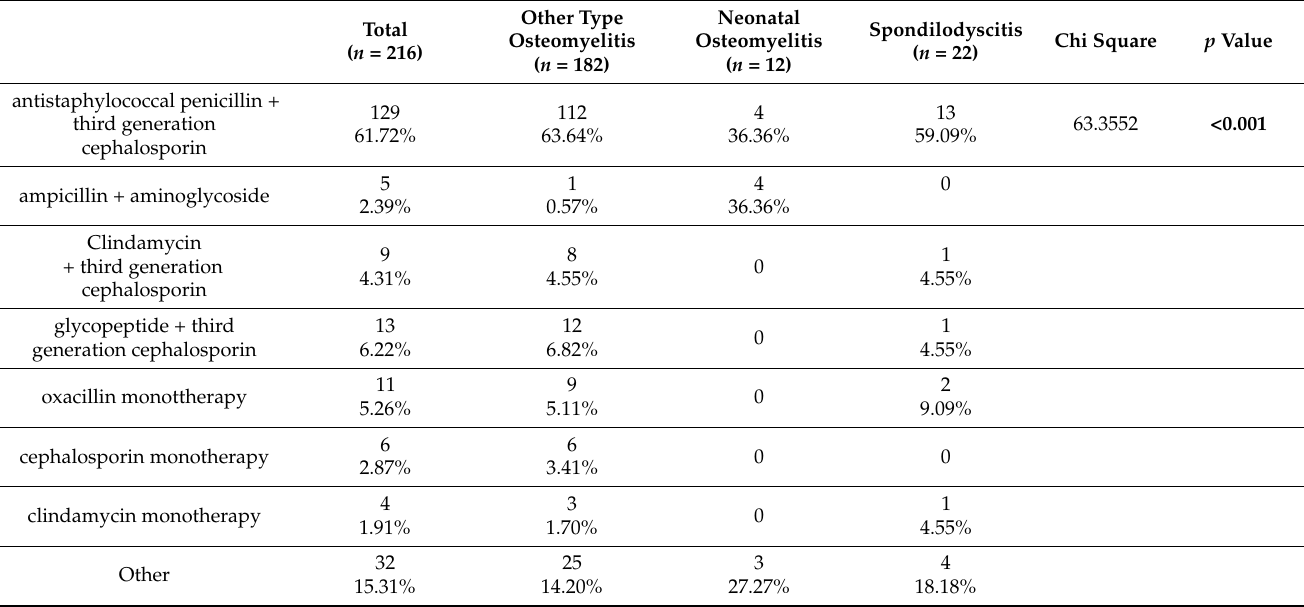
Table 5. First line intravenous antibiotic therapy.